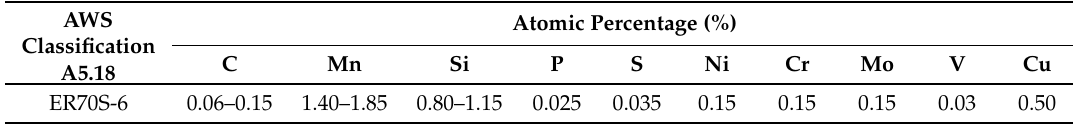
Table 2. Chemical compositions of the solid electrode using a